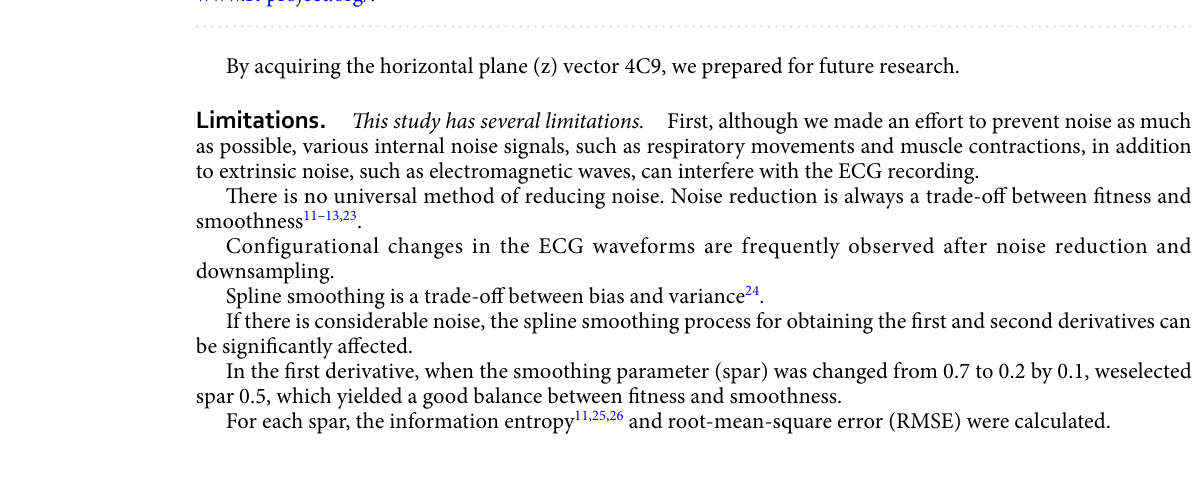
Figure 6. Plot of the first three IC scores (top row) and the first three PC scores (bottom row) for a combination of the landmark data. The red numbers indicate normal subjects, and the blue numbers indicate LQTS3 patients. IC2 yields quite good separation between normal subjects and LQTS3 patients. R version 4.0.2 URL https:// www.R- proje ct.